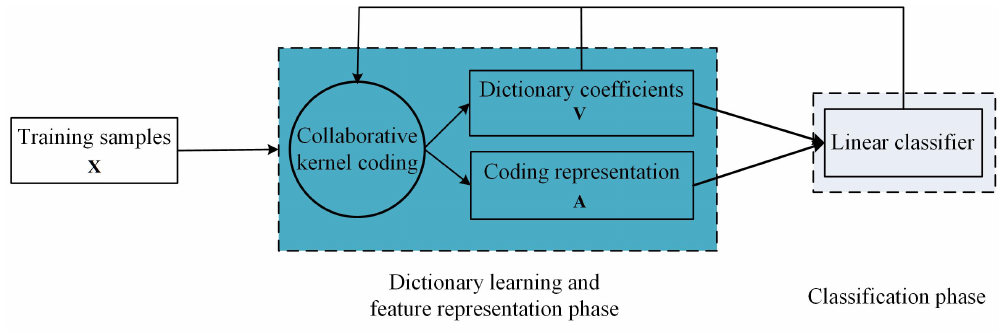
Figure 5. The illustration of the proposed